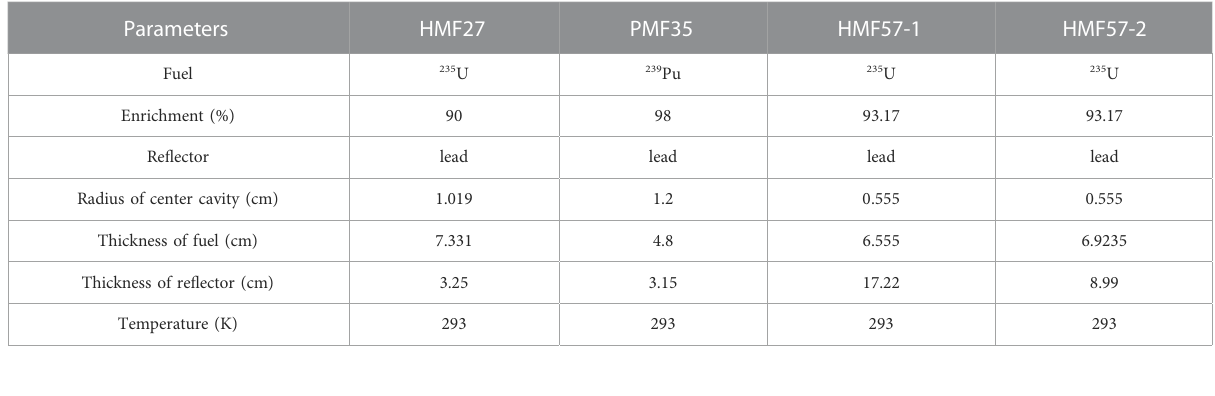
TABLE 2 Geometric and material parameters of the critical experiments.